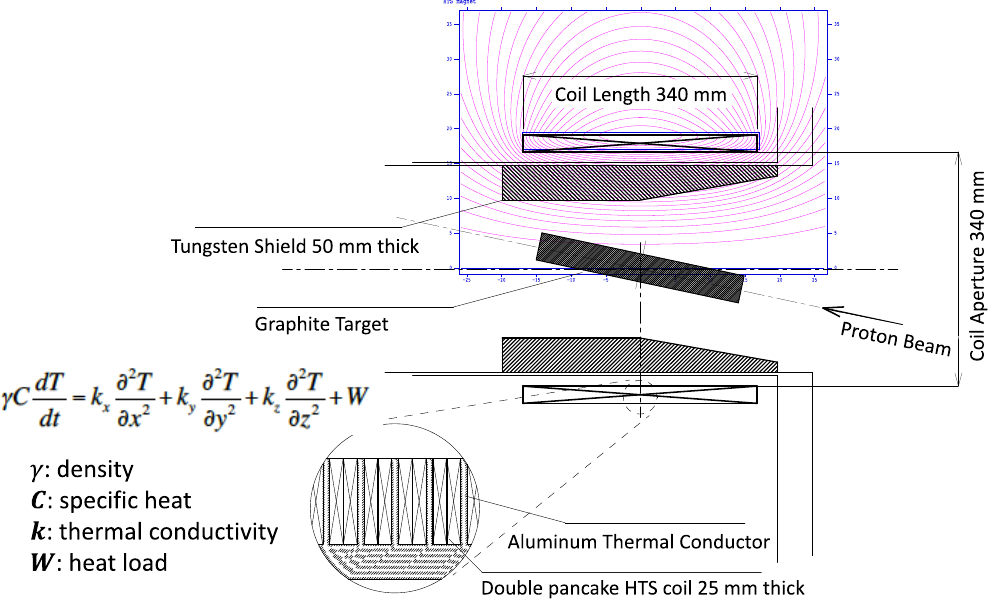
Figure 3. Conceptual design of HTS-based muon production solenoid.